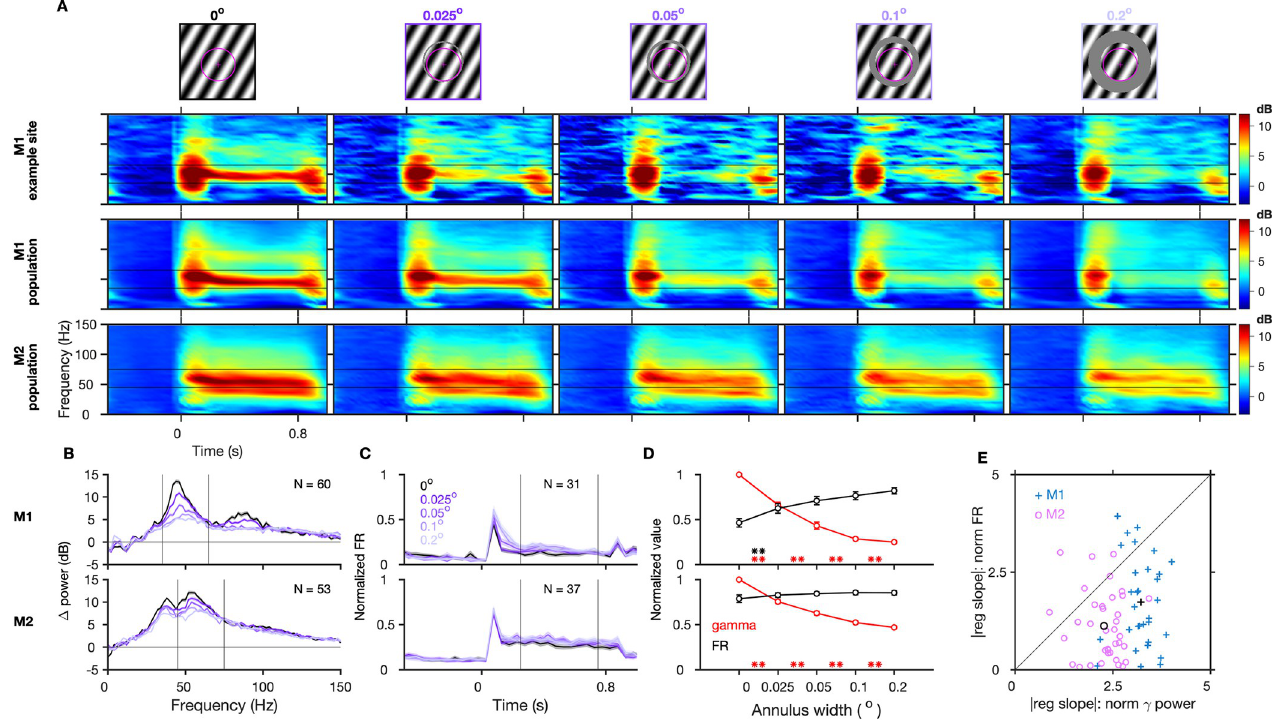
Fig 1. Gamma oscillations are reduced by annular discontinuity. AU : AbbreviationlisthavebeencompiledforthoseusedinFigs 1 (cid:0) 6 ; 8 ; andS 1 (cid:0) S 3 : Pleaseverifythatallentriesarecorrect : (A) Top row: grating stimuli with annular cut discontinuity along with the RF (magenta) of an example center site in M1 from an example session (cut width is mentioned and color coded for other plots). Trial-averaged TF difference spectra for the example center site in M1 (second row), and for the population (averaged across center electrodes and sessions) in M1 and M2 (following rows; number of sites, N = 60 and 53, respectively). Gratings were presented between 0 to 0.8 s. (B) The corresponding mean change in power from baseline ([–0.5 to 0]s) to stimulus period ([0.25 to 0.75]s), averaged across these electrodes and sessions. Black lines in (A) and (B) indicate the gamma ranges (35–65 Hz and 45–75 Hz for the 2 monkeys). (C) Mean normalized firing rate (averaged across selected spiking center electrodes and sessions) for different conditions. (D) Mean normalized gamma power and firing rate during the stimulus period (black lines in (C)) normalized across different annular discontinuity values. The shaded regions and error bars denote the SEM; asterisks in (D) indicate statistical significance ( �� for p < 0.01, � for p < 0.05, WSR test) of change in normalized gamma (red) or firing rate (black) between the flanking values of annulus widths. (E) Magnitude of slope of regression with annulus width ( Δ value/degree of visual angle) of normalized gamma power versus normalized firing rate. Each data point represents a selected center electrode; black data points indicate the mean across them. Figure data are located at https://doi.org/10.5281/zenodo.6523772. M1, Monkey 1; M2, Monkey 2; RF, receptive field; SEM, standard error of mean; TF, time frequency; WSR, Wilcoxon signed rank.